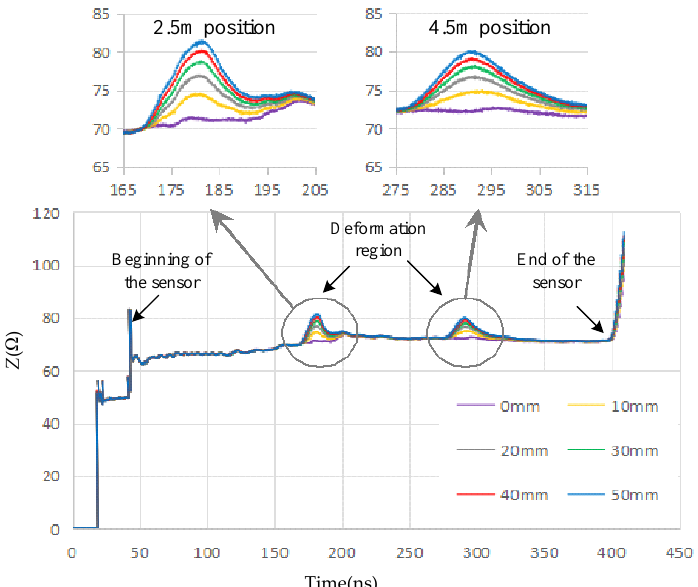
Figure 11. Sampling characteristic impedance curves.